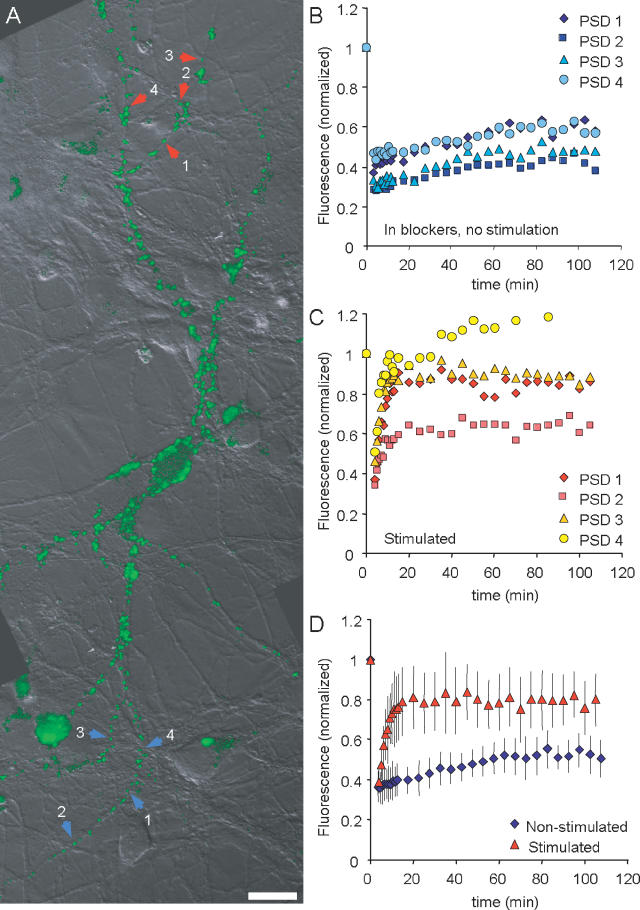
GFP:ProSAP2 Loss and Reincorporation Rates Are Accelerated by Synaptic Activity(A) A neuron (23 d in vitro) expressing GFP:ProSAP2 that was maintained for 7 d in glutamate receptor blockers (10 μM CNQX and 50 μM AP-5). Four PSDs (blue arrows at bottom of image) were photobleached and the recovery of fluorescence at these sites was monitored (B). Then, the preparation was switched to blocker-free solution and four other PSDs (red arrows at top of image) were photobleached. After collection of the first set of postphotobleach images, the preparations were stimulated at 20 Hz for 20 s every 3 min while monitoring the recovery of the photobleached PSDs (C). A comparison of mean recovery kinetics for both sets of photobleached PSDs (D) reveals that recovery kinetics were greatly accelerated by the stimulation protocol, indicating that the loss and reincorporation kinetics of ProSAP2 at individual PSDs are accelerated by synaptic activation. Note that PSD 4 from (C) was not included here as its final fluorescence exceeded its original level, indicating that the size of this PSD may have changed during this experiment. All data are shown after correcting for ongoing photobleaching as in Figure 3. Bar in (A), 20 μm.